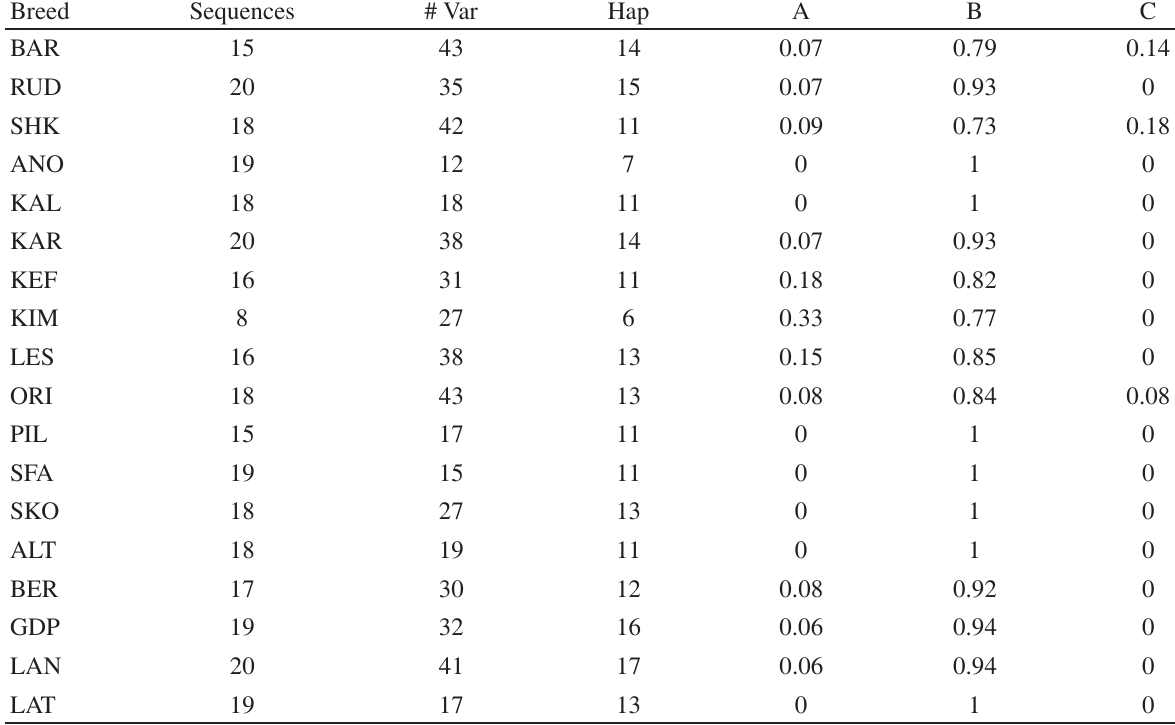
TABLE 5: Sequences analysed, number of variable sites (# Var), number of haplotypes (Hap), and percent- age of haplotypes in the haplogroups A, B, or C per breed. Breed Sequences # Var Hap BAR RUD SHK